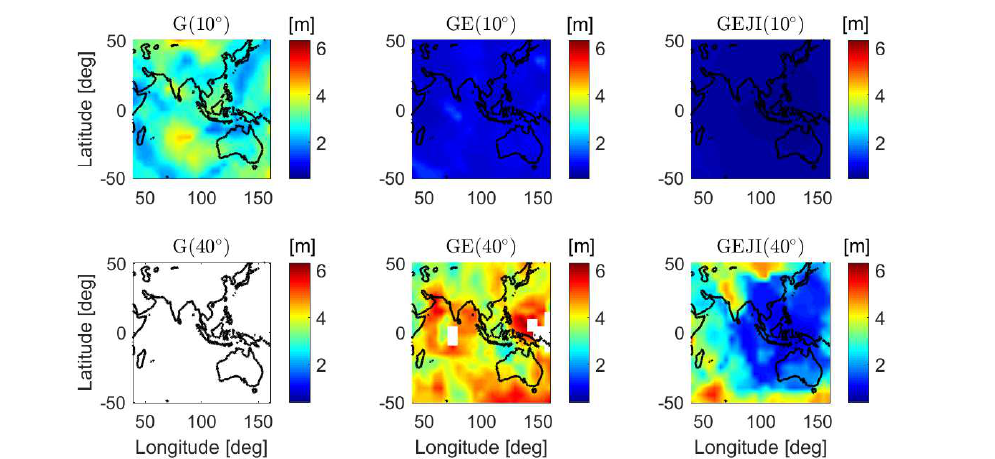
Figure 9. Average formal standard deviations of the ambiguity-float height errors on DOY 224, 2018. The data sampling interval is 30 s.